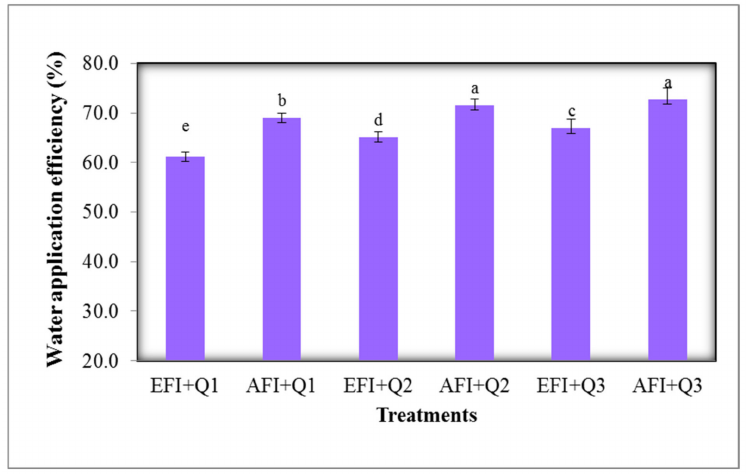
Figure 3. Effect of irrigation systems (EF and AF) and flow rates (0.47 (Q1), 0.95 (Q2), and 1.43 L/s (Q3)) on water application efficiency across the two seasons. Mean values followed by the same letter were not significantly different at the 5% level between treatments.